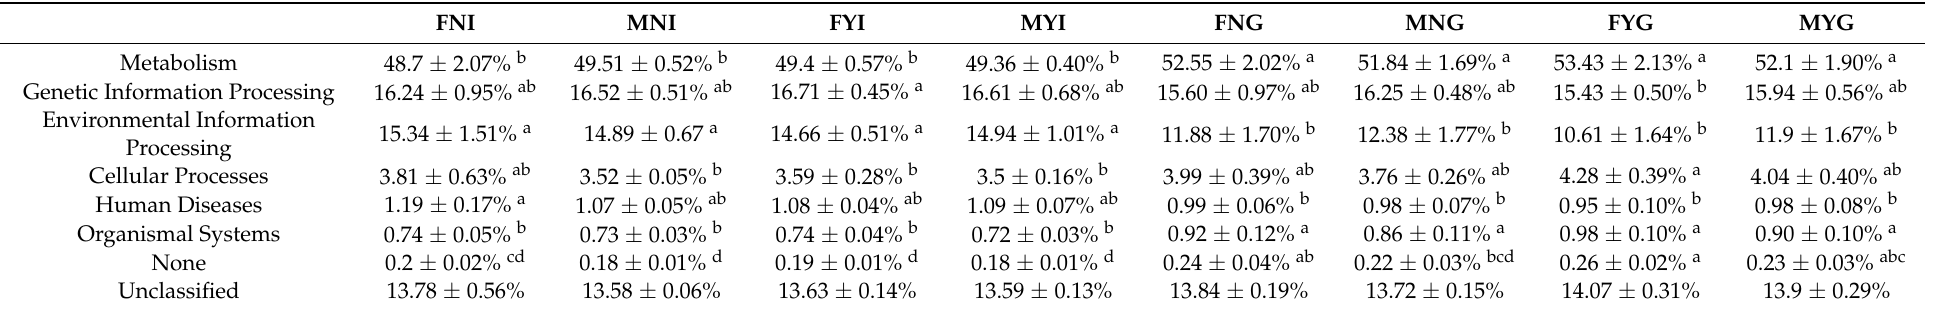
Table 1. The predicted KEGG function classification of intestinal and gill tissues of dwarf-form